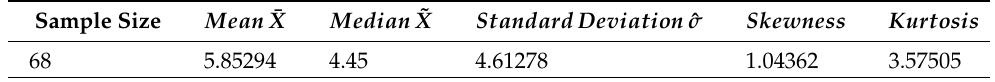
Table 10. Summary statistics of data-II.